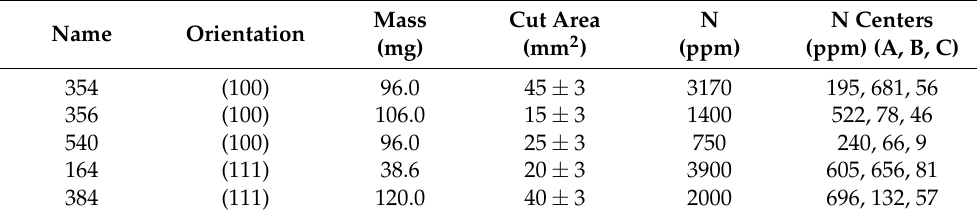
Table 1. Sample name, surface orientation, mass, cut area, total nitrogen concentration (N) and concentrations of the A, B and C centers of the natural diamond